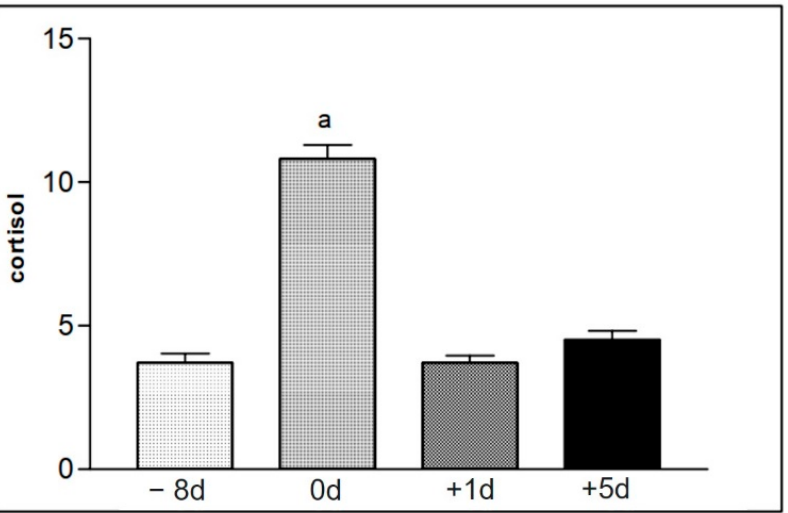
Figure 10. Representation of the mean values of serum cortisol levels of samples from animals in group II (16 to 30), found at the different moments of collection defined as − 8 d, 0 d, +1 d, and +5 d. Statistical difference according to the Tukey–Kramer test—Beltsville, 2003. a = significant statics difference.